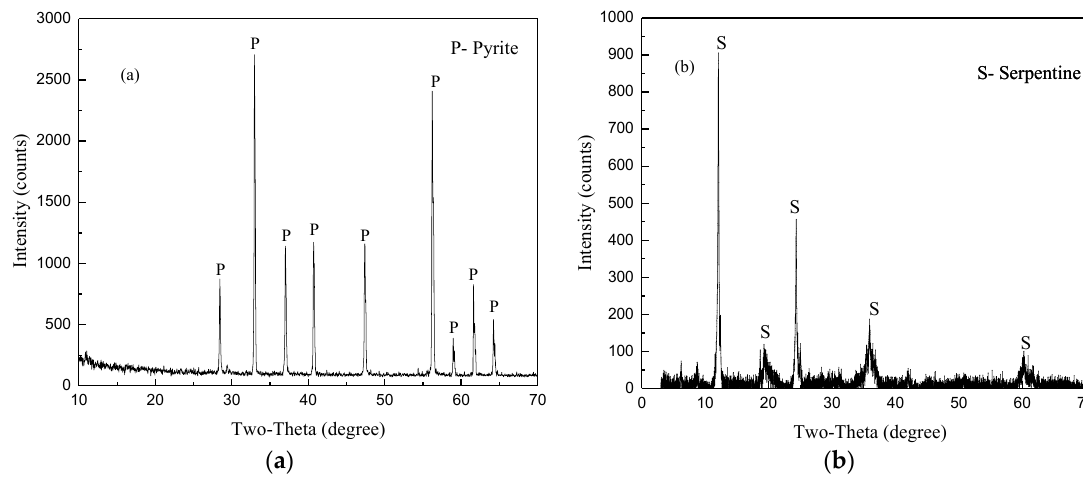
Figure 1. XRD patterns of the (a) pyrite and (b) serpentine.